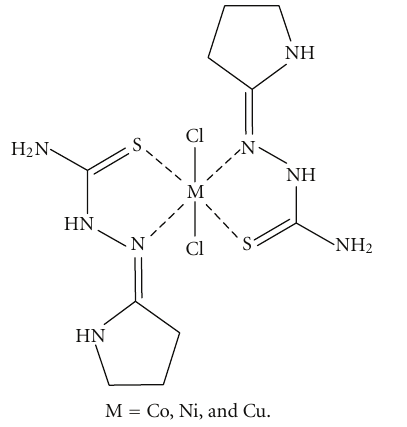
Figure 1: Structures of the complexes.